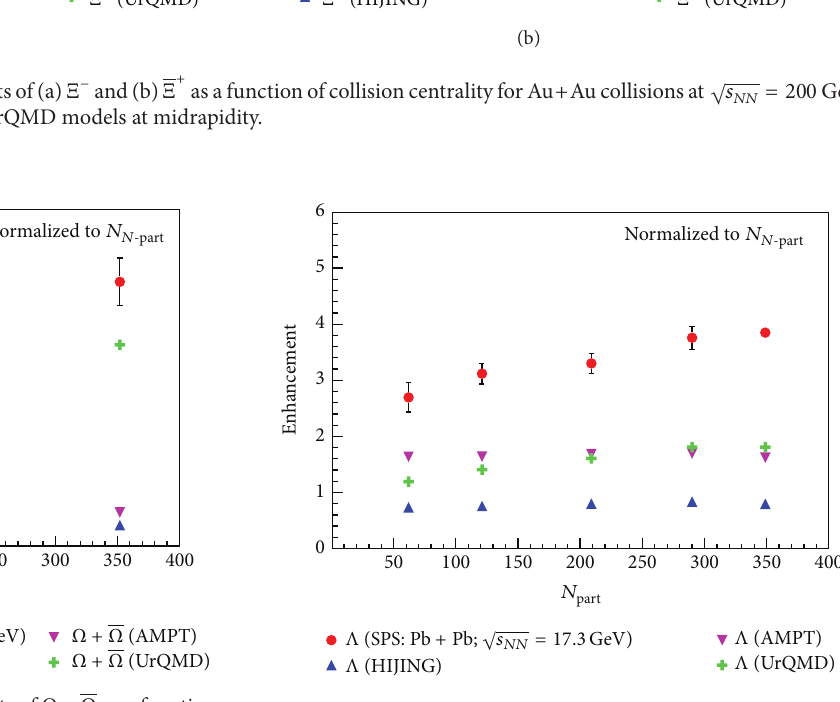
Figure 4: 𝑁 𝑁 -normalized enhancements of Λ as a function of -part collision centrality for Pb + Pb collisions at √𝑠 𝑁𝑁 = 17.3 GeV are compared with HIJING, AMPT, and UrQMD models at midrapid-